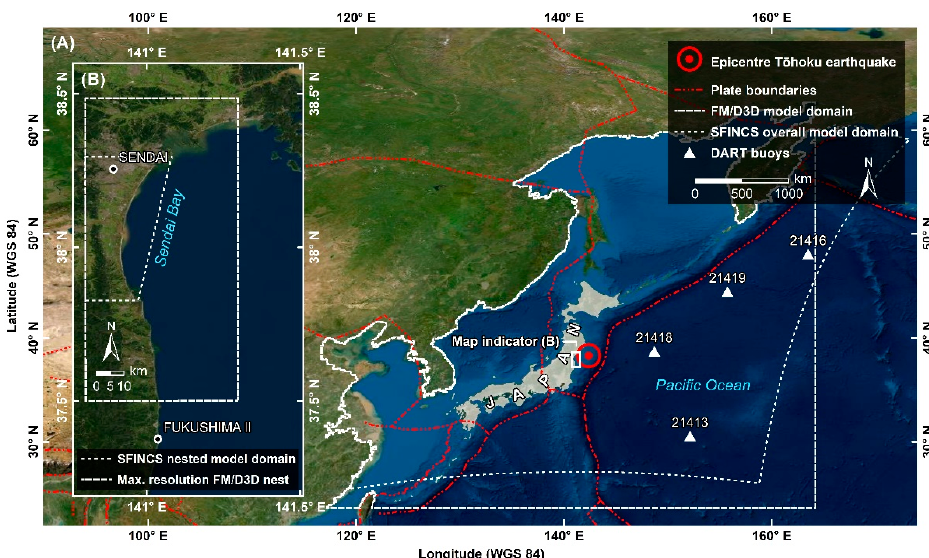
Figure 1. ( A ) Satellite image and bathymetry of the Northwestern Pacific Ocean and Japan including the location of the epicentre of the 2011 T ō hoku earthquake, major plate boundaries, the location of four DART (Deep-ocean Assessment and Reporting Tsunami) buoys and the domains of the D-FLOW Flexible Mesh (FM) as well as of the overall Delft3D-FLOW (D3D) and SFINCS models, which are applied in this study. ( B ) Satellite image of the Sendai Bay and surroundings including the area of maximum resolution of the FM model and the domain of the nested SFINCS/D3D models of this study.